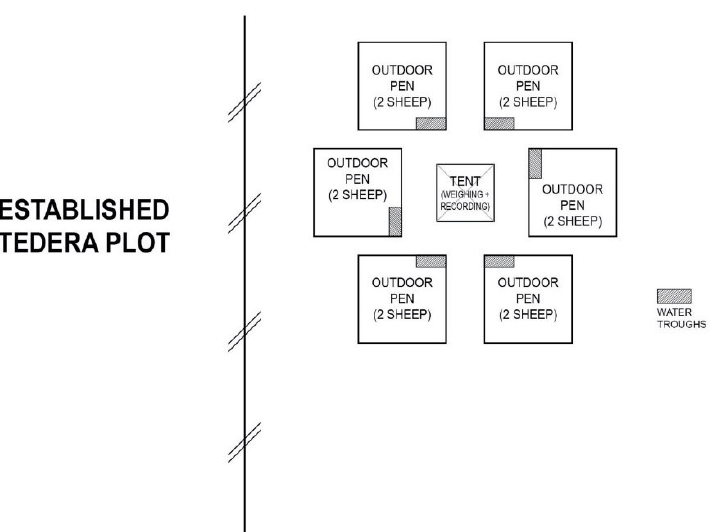
Figure 1. Schematic of the pen feeding experiment illustrating the layout of the six pens, the central tent for recording measurements and proximity to the established tedera.